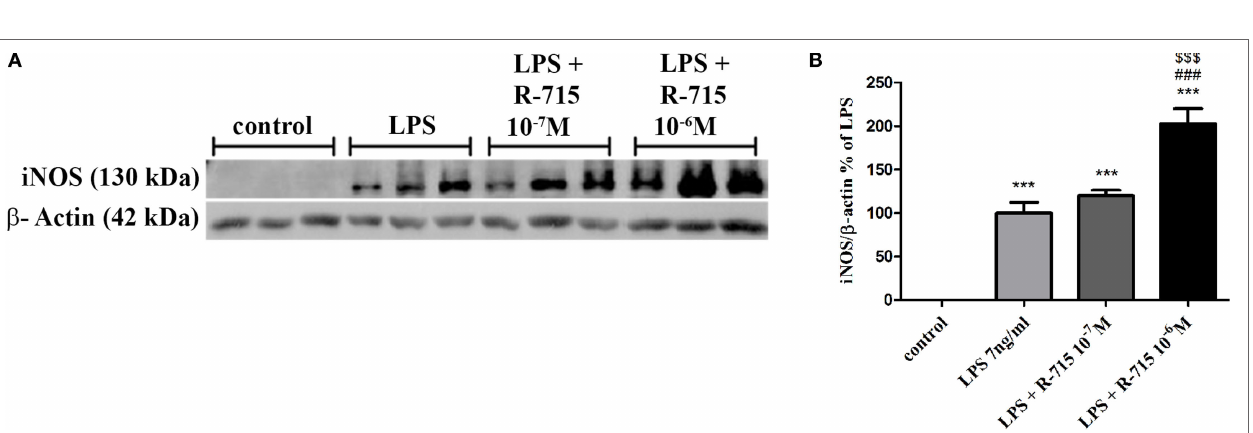
FigUre 3 | effect of the bradykinin B 2 receptor (B 2 r) antagonist on basal and lipopolysaccharide (lPs)-induced nO and tumor necrosis factor-alpha (TnF- α ) release from BV2 cells . Cells were incubated with the B 2 R antagonist HOE 140 (10 − 6 M) in the presence or absence of LPS (7 ng/ml) for 24 h. NO (a) and TNF- α (B) levels were measured in the media, and the cells were counted. Results are representatives of three independent experiments and are presented as mean ± SEM, n = 3–6; statistical significance was assessed by one-way analysis of variance followed by a Tukey–Kramer Multiple Comparison Test; *** P < 0.001 versus